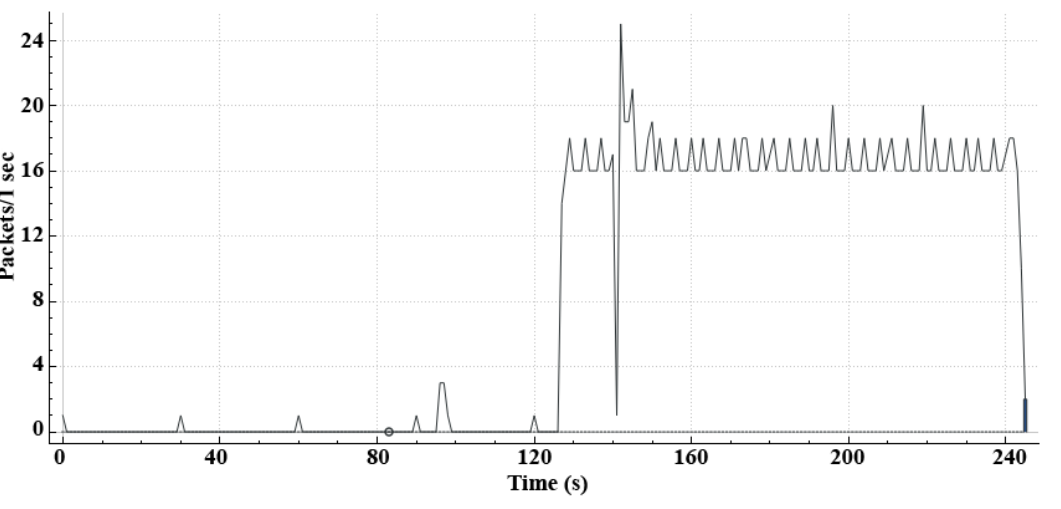
Figure 9. The graph includes the network traffic generated between the M-DUINO and the OPC UA